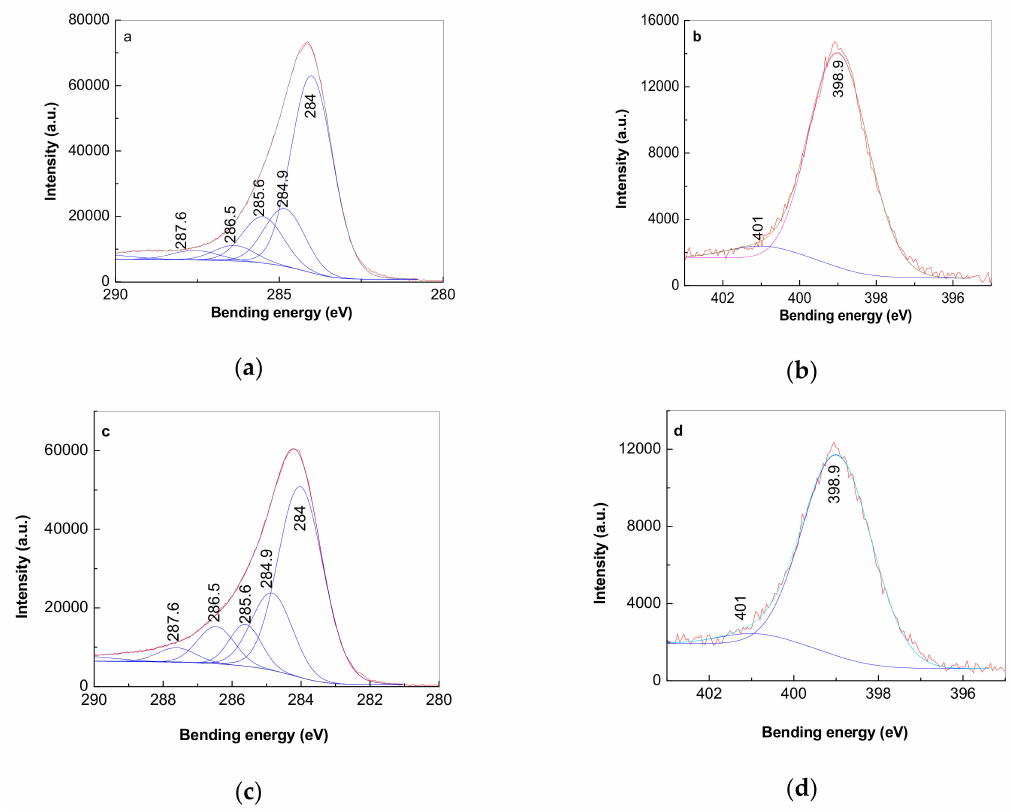
Figure 3. XPS C1s spectra of 5A1N ( a ) and the 5A1N / RGO composite ( c ). XPS N1s spectra of 5A1N ( b ) and the 5A1N / RGO composite ( d